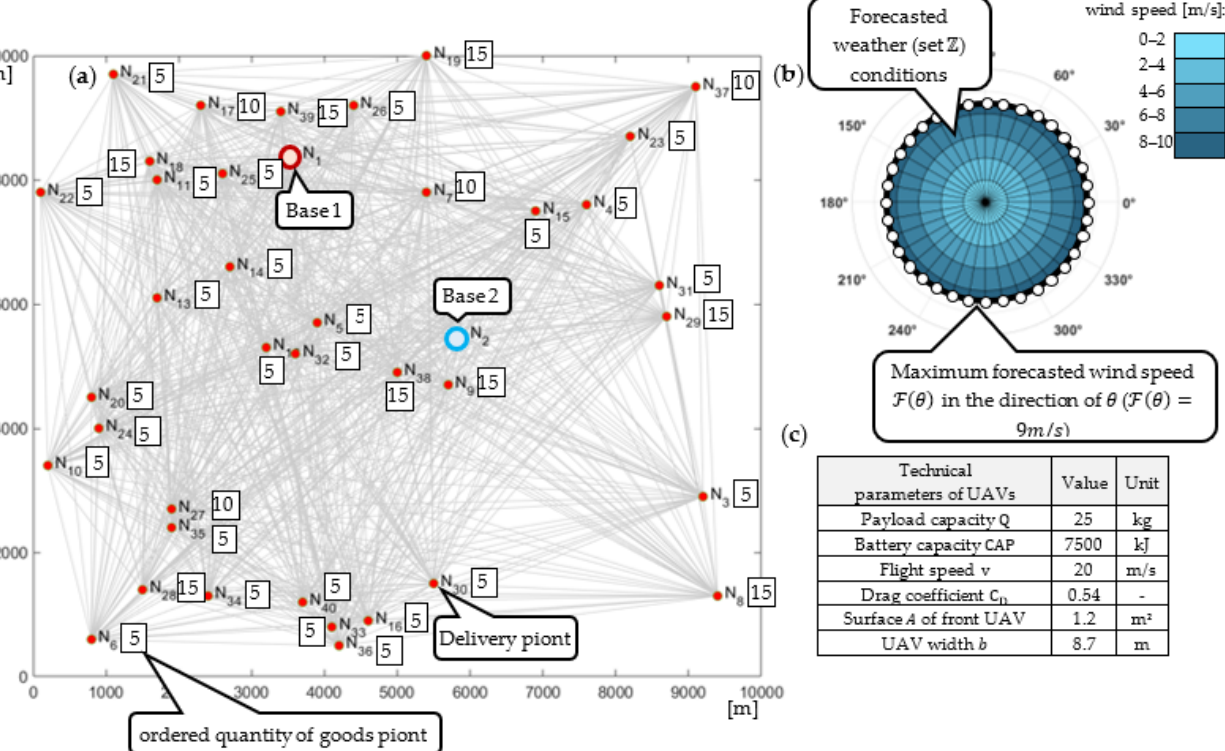
Figure 1. Graphical illustration of distributed delivery problem: distribution network (a); forecasted weather conditions (b); parameters of the UAVs (c)